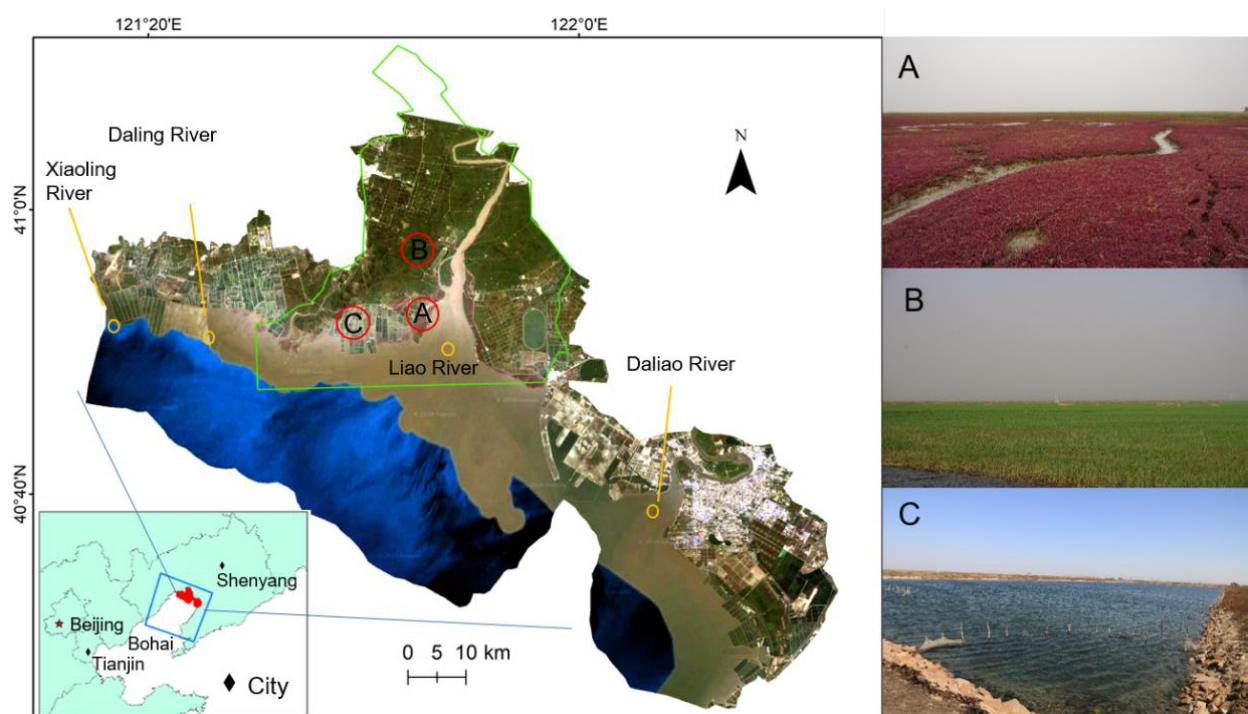
Figure 1. Location of study area in 2018 (data sources: Google satellite imagery). The right panels show ( A ) seepweed, ( B ) reeds, and ( C ) aquaculture ponds. The green line represents the boundaries of national nature reserve.